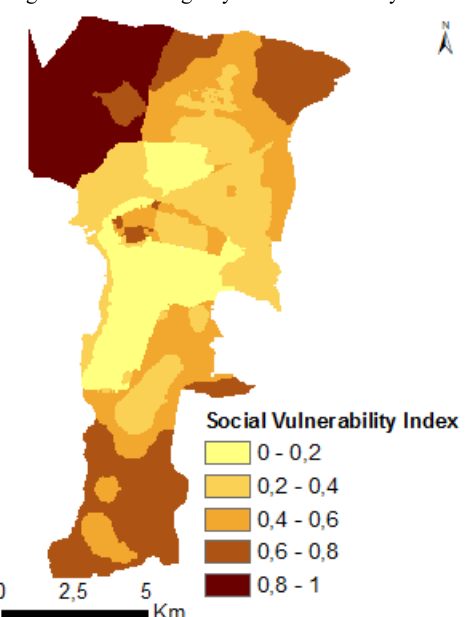
Figure 11. Housing quality in Bujumbura city.